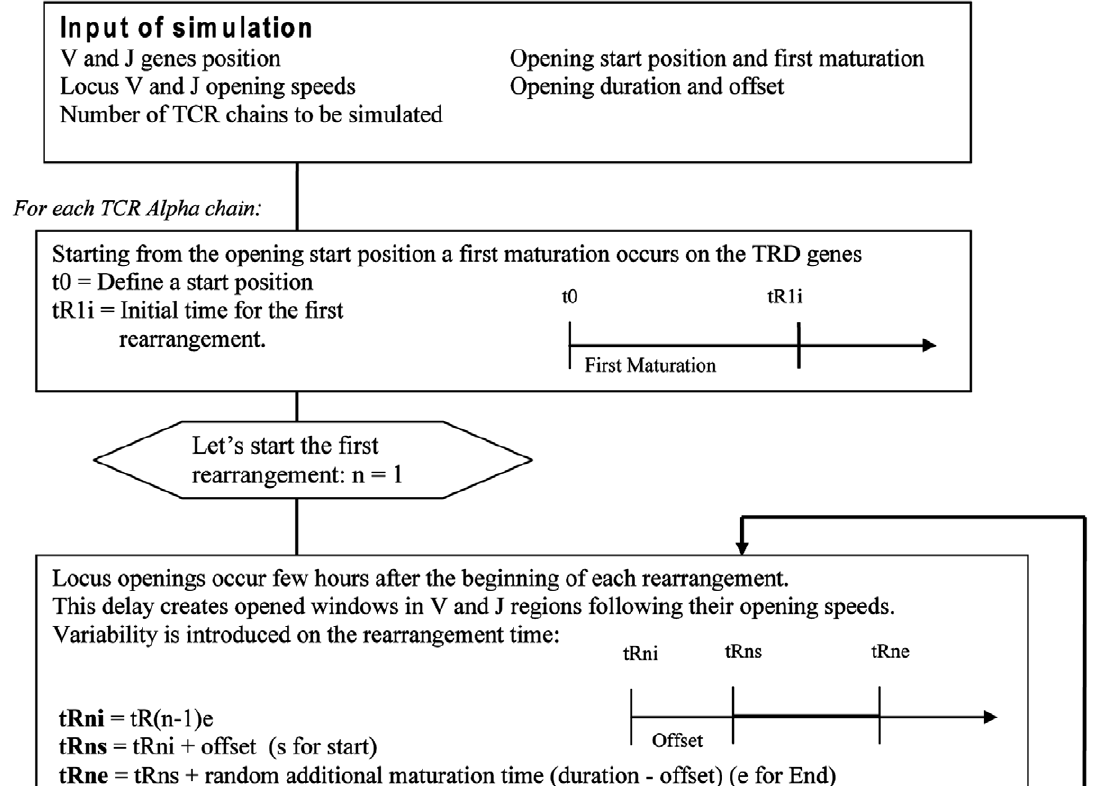
PLoS Computational Biology |